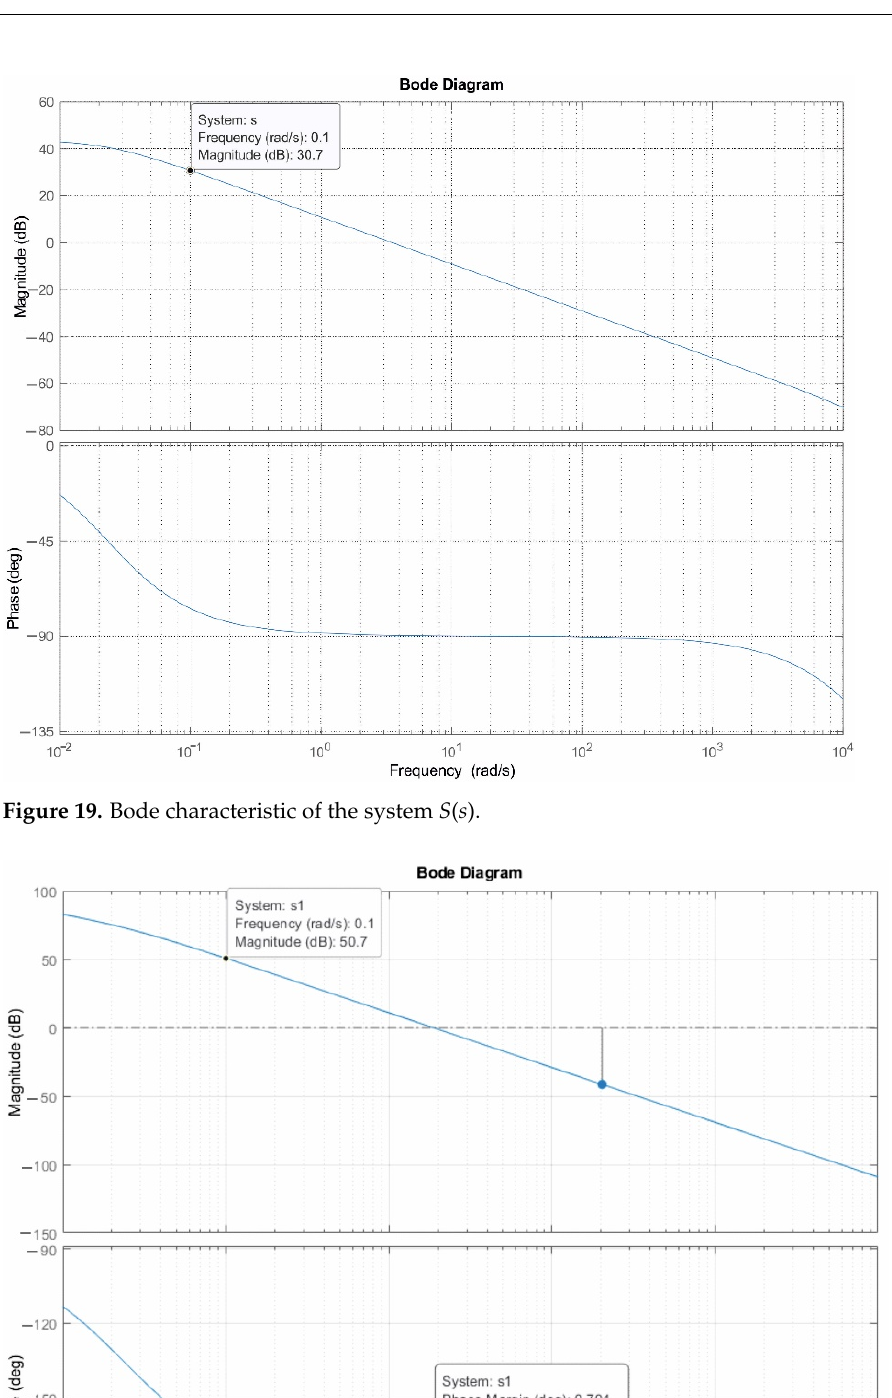
Figure 21. Bode characteristic of the system after applying phase advance. The controller includes a low-pass filter of the 2nd order with transmission, which allows the suppression of signal noise in the high-frequency range, Equation (18) and Fig- ure 22.